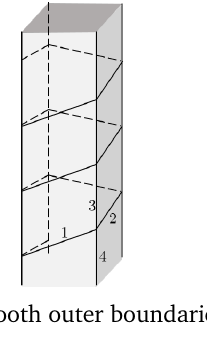
Figure 17: The minimal structure of a smooth screw